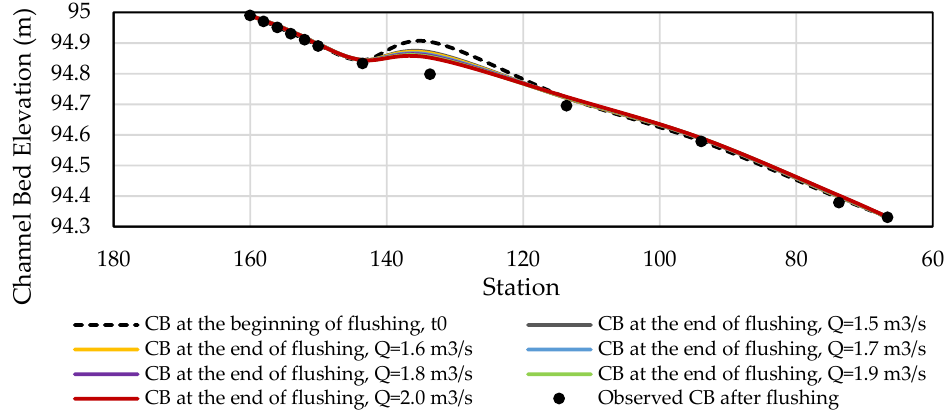
Figure 13. Flushing optimization results (discharge interval = 0.1 m 3 /s). There are six discharges that were compared: 1.5, 1.6, 1.7, 1.8, 1.9, and 2.0 m 3 /s.